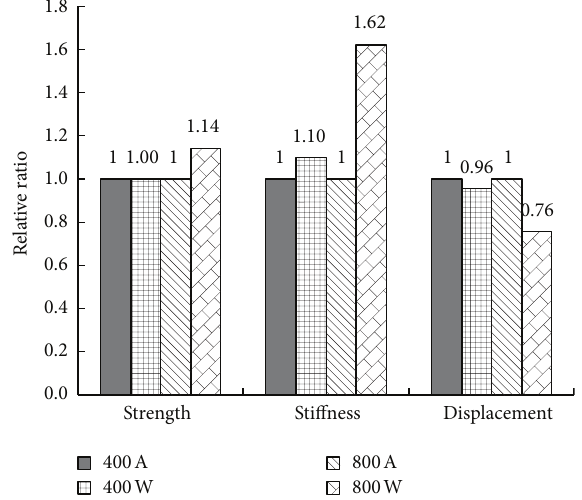
Figure 7: Influence of cooling regimes on compressive strength, stiffness, and displacement corresponding to peak load.